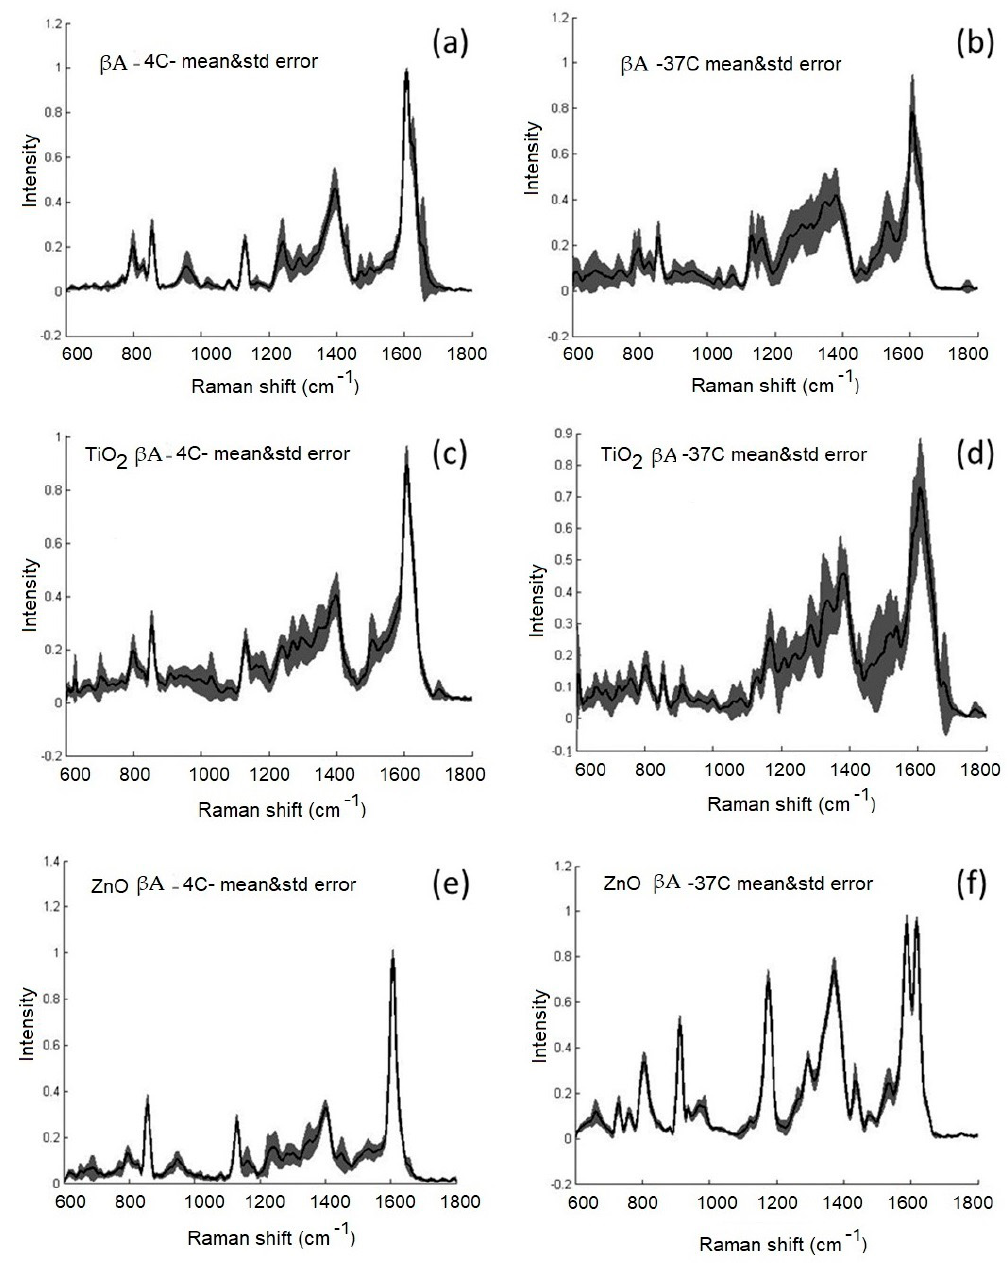
Figure 5. Averaged SERS spectra ( n = 8–21) of suspensions of: ( a , b ) β A solution (10 nM); ( c , d ) TiO 2 - NPs coated with β A; ( e , f ) ZnO-NPs coated with β A, at 4 °C and 37 °C with standard errors.